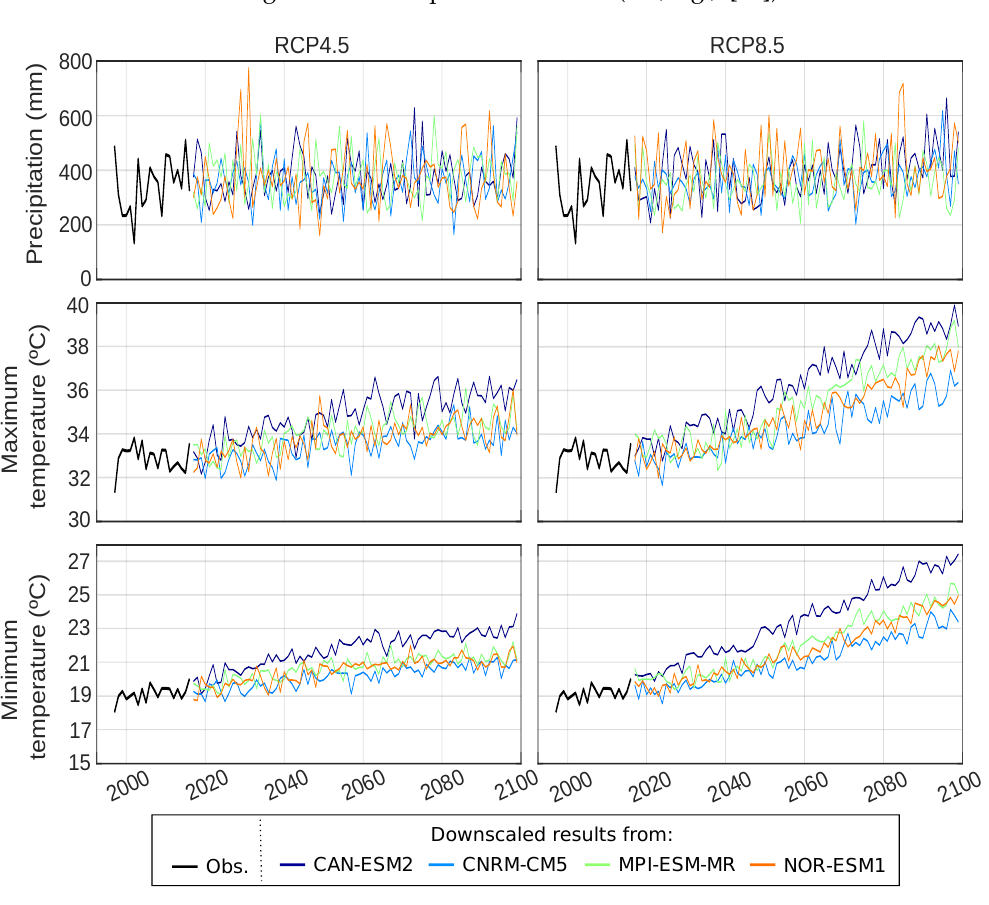
Figure 6. Projections of annual precipitation, maximum and minimum temperature (in rows) av- eraged along the 15 PMD stations considered up to 2100, as obtained from statistical downscaling. Colors represent the different ESMs used under the RCP4.5 and RCP8.5 scenarios ( left and right column, respectively). For completeness, the available observations for the period 1997–2016 are given in